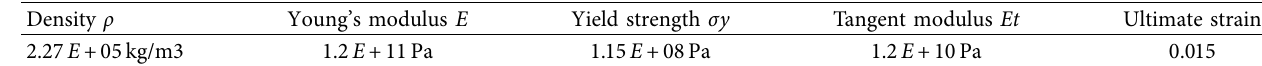
Table 2: Cowper-Symonds model parameters (unit: N, m, Pa, s).